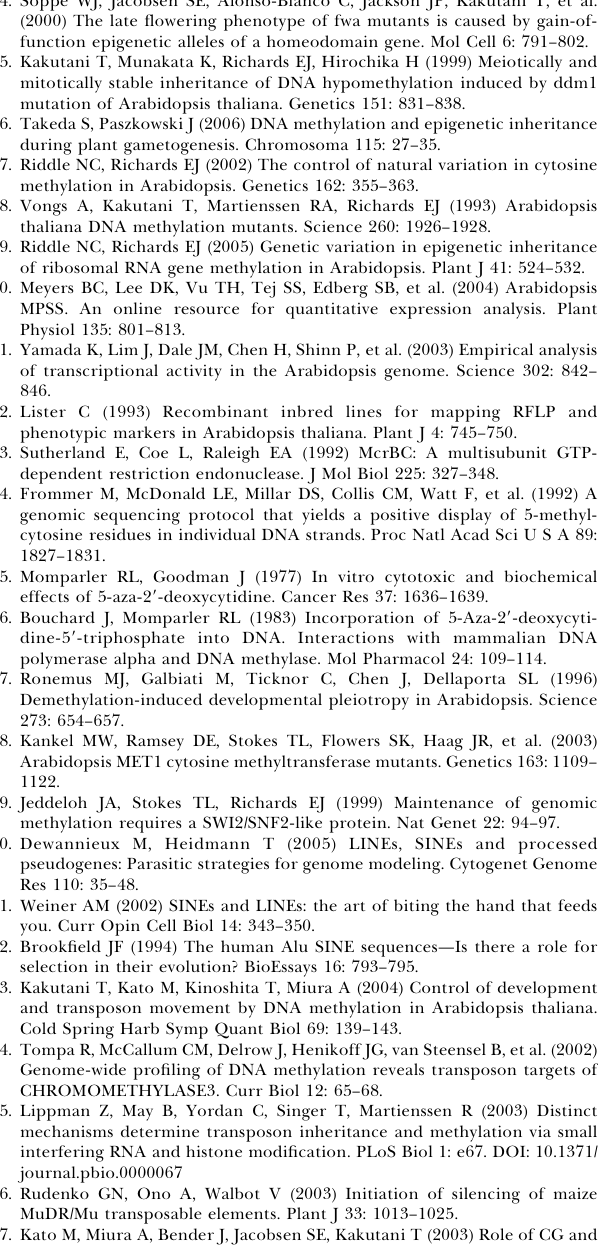
The GenBank (http://www.ncbi.nlm.nih.gov/Genbank) accession num- bers for the At2g10410 genomic region sequences in Ler and Ra-0 strain backgrounds are DQ385059 and DQ385062,